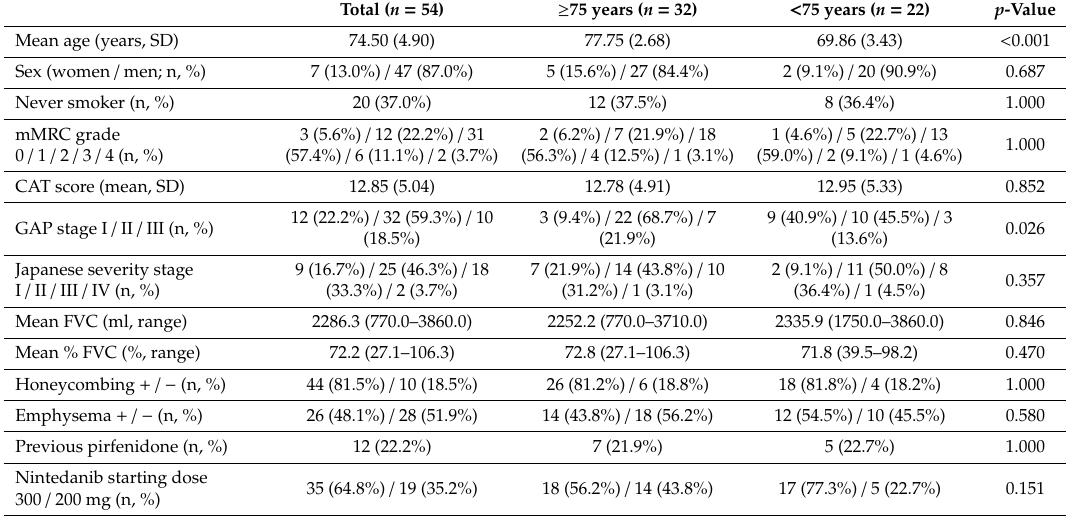
Table 1. Baseline Patient Characteristics of All 54